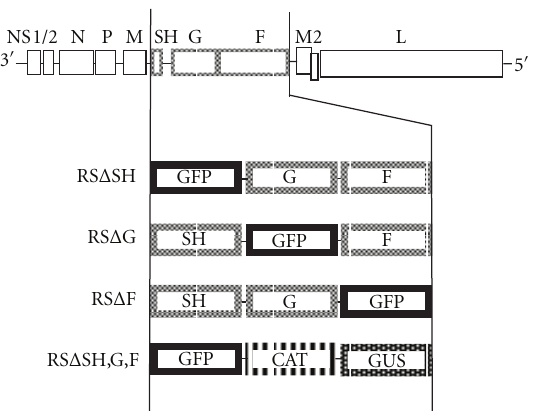
Figure 1: Schematic of the gene content of engineered viruses. All engineered viruses were generated from a cDNA of the A2 strain of HRSV. Viruses RS Δ SH, RS Δ G, and RS Δ F are missing the ORFs of the SH, G, and F genes, respectively, which have been substituted with that of GFP. Virus RS Δ SH,G,F has the ORFs encoding each of the three HSRV glycoproteins replaced with those of reporter genes GFP, CAT, and GUS,